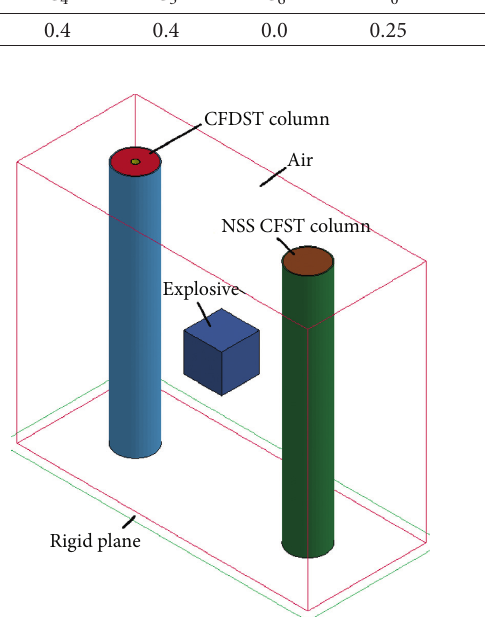
Figure 8: Sketch of geometric